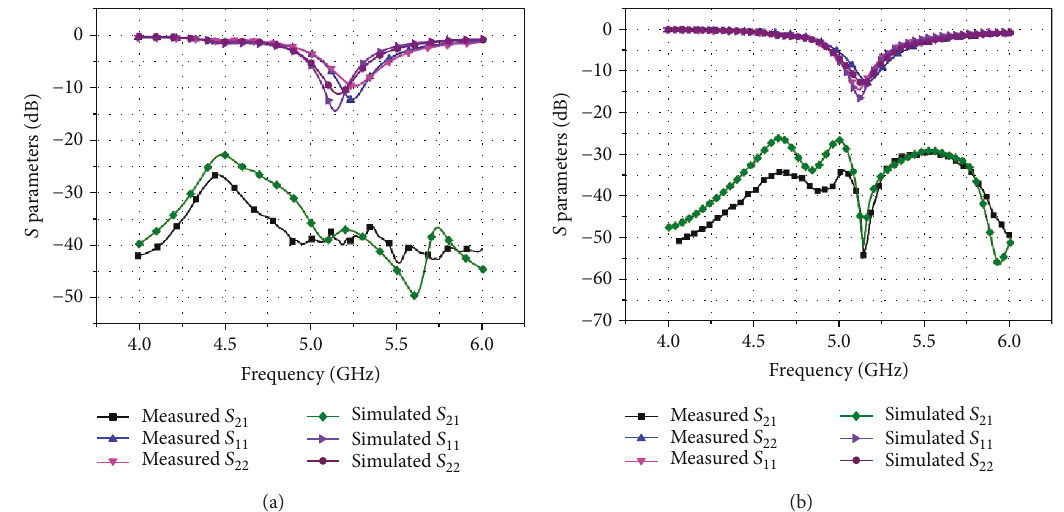
Figure 8: (a) Simulated and measured S parameters of prototype C. (b) Simulated and measured S parameters of prototype D.